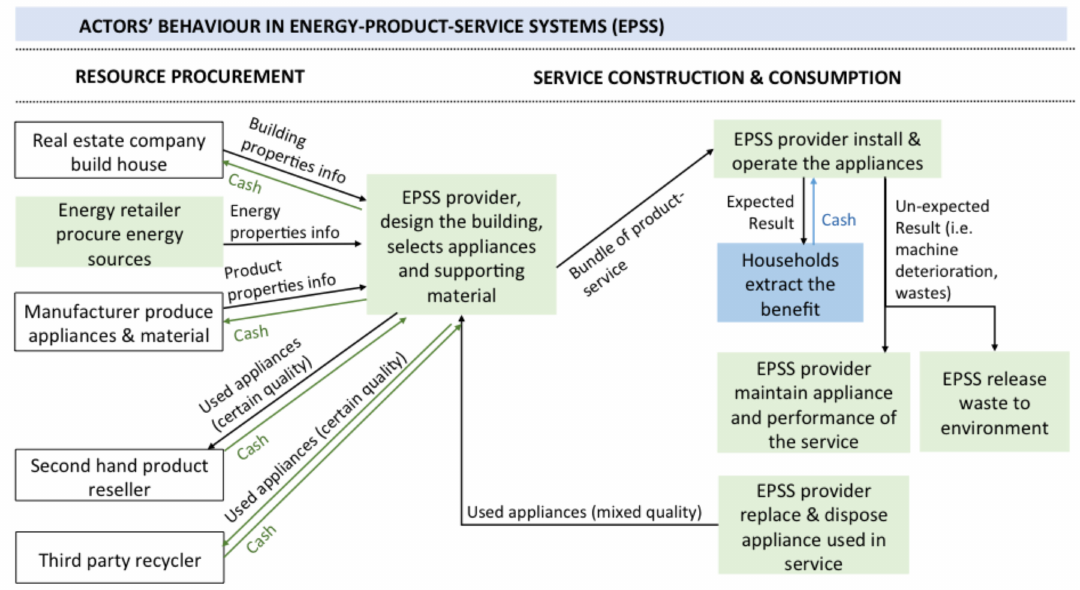
Figure 3. Actor’s behaviour in